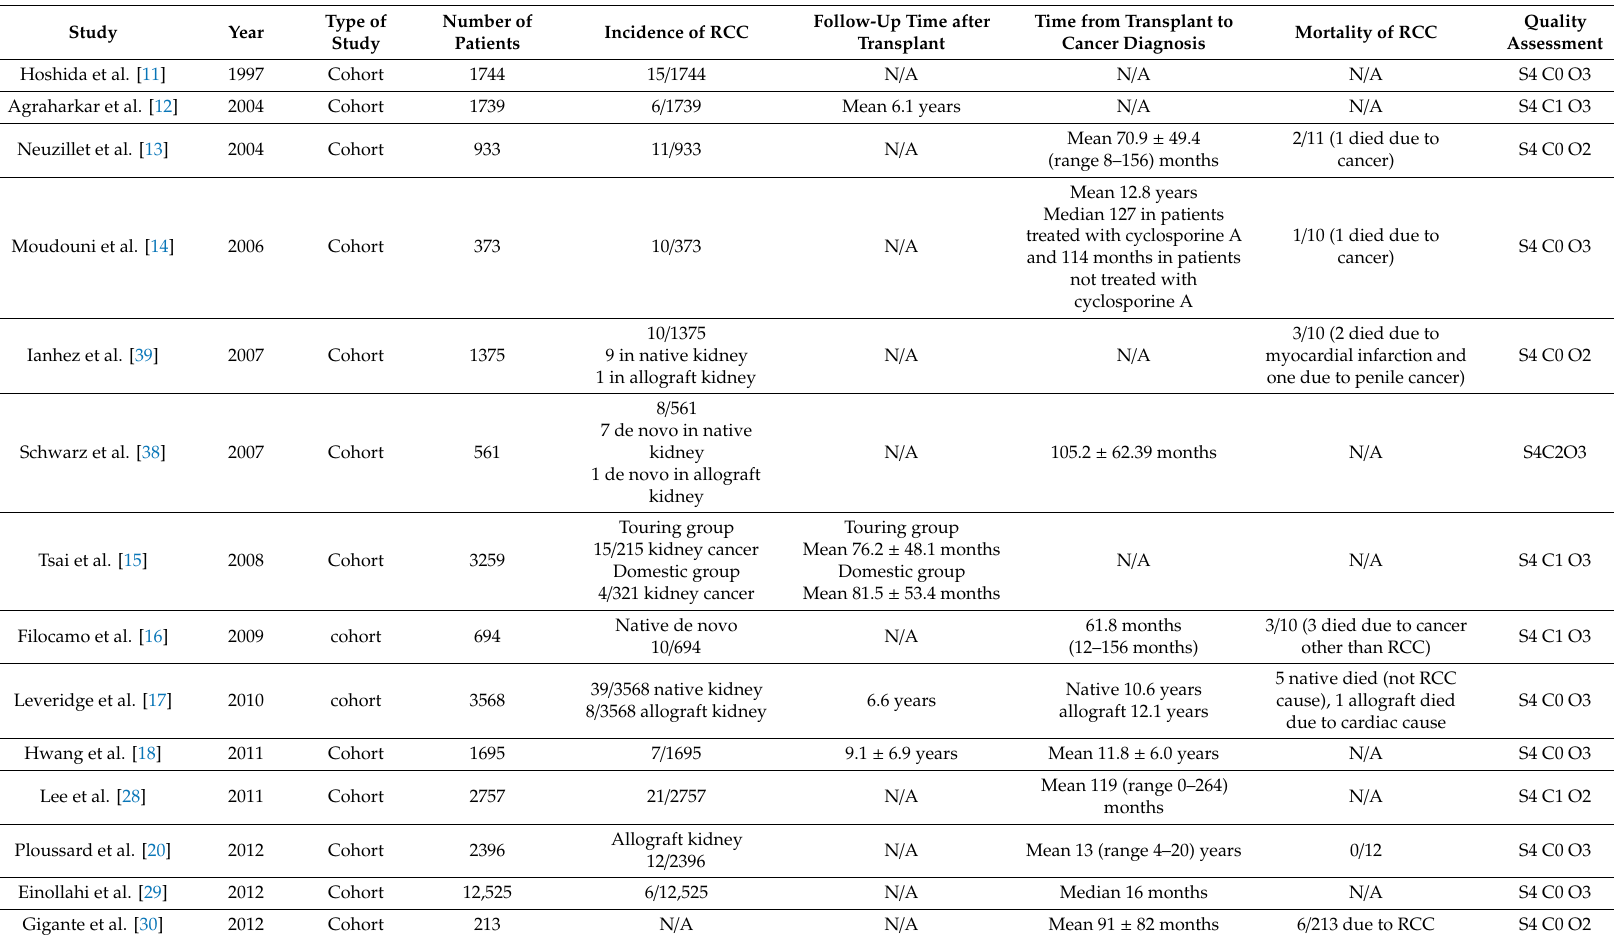
Table 1. Main characteristics of studies included in the meta-analysis of incidence and mortality of renal cell carcinoma (RCC) after kidney